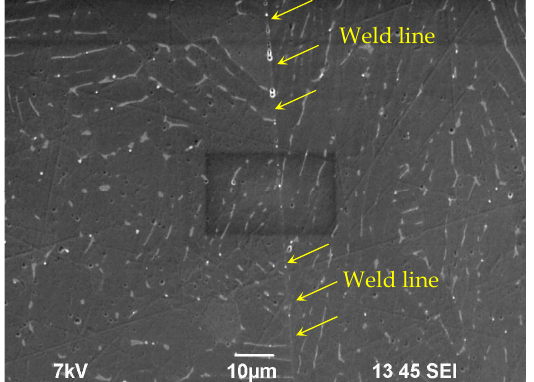
Figure 2. Position of the corrosion area relative to the welded joint. Specimen of the coarse-grained alloy (V h = 10 °C/min, T = 700 °C, t = 10 min, P = 50 MPa) after the electrochemical testing. The joint line is marked by yellow arrows. The corrosion area of 0.3 × 0.2 mm 2 in size has darker borders. SEM.